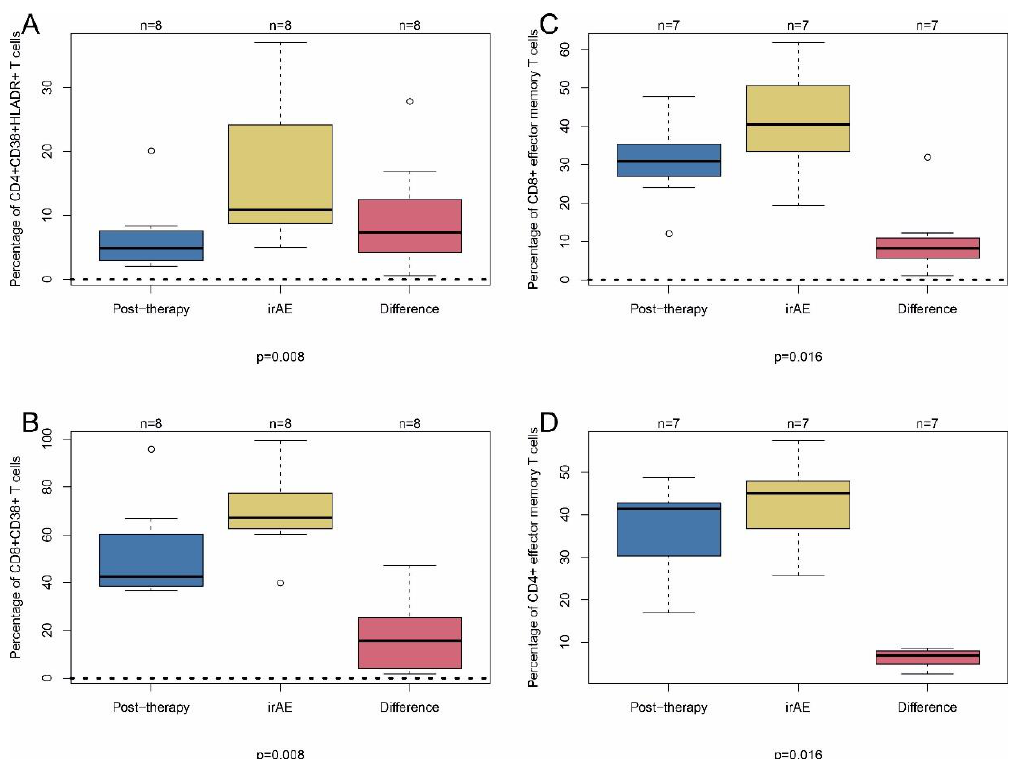
Figure 6. Inflammatory T cell subpopulations in patients with irAE. PBMC were taken from patients immediately after first treatment on the same day (post-treatment; time point 2 in previous figures). In addition, PBMC were taken from patients at the time point of first appearance of adverse events (irAE) and analyzed by flow cytometry (FACS). The red boxplots illustrate the pairwise difference of post-first treatment and irAE measurements. ( A ) CD4 + CD38 + HLADR + T cells. ( B ) CD8 + CD38 + T cells. ( C ) CD8 + effector memory T cells. ( D ) CD4 + effector memory T cells. Nominal (unadjusted) p -values (Wilcoxon signed-rank test between post-therapy and irAE) are shown without adjustment for multiple testing. Data in (A) are given as percentage of CD38 + HLADR + cells total CD4 + cells. Data in ( B ) are given as percentage of CD38 + cells of total CD8 + cells. Data in ( C , D ) are given as percentage of CD4 + and CD8 + effector memory cells, respectively, of total CD4 + and CD8 + cells.